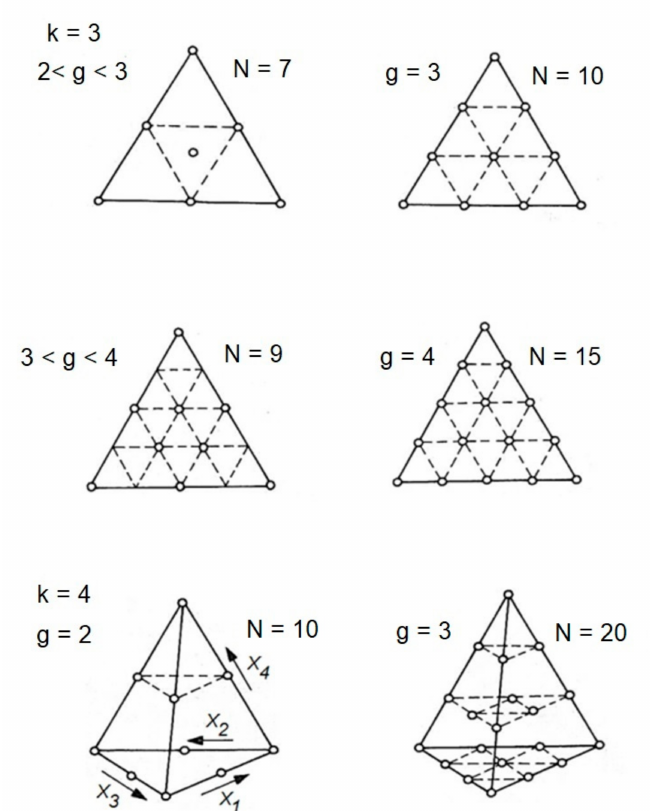
Figure 1. Number of experimental points for 3 and 4 components (k). N—number of experimental points; g—the degree of the regression polynomial [18].